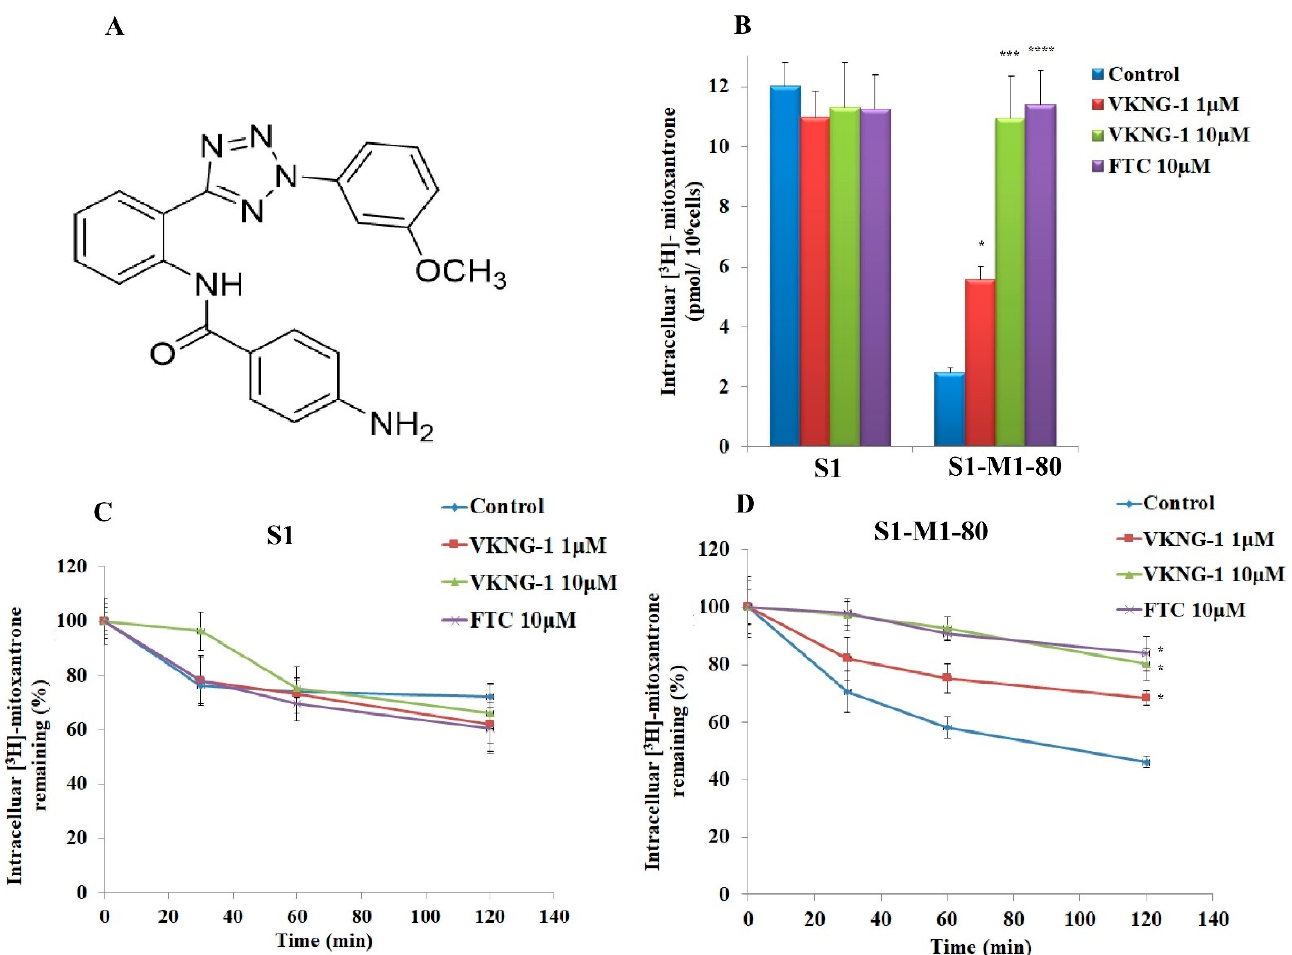
Figure 2. Chemical structure of VKNG-1 ( A ). The outcome of VKNG-1 activity on the cellular accumulation of ( 3 H)- mitoxantrone in S1 and S1-M1-80 cells ( B ). Data of VKNG-1 on the efflux of the substrates of ABCG2. A graph was plotted with time course (0, 30, 60, 120 min) on the X -axis versus the percentage of intracellular ( 3 H)-mitoxantrone remaining (%) on the Y -axis and showed the effect of VKNG-1 in S1 ( C ), S1-M1-80 ( D ) cells. Columns depict triplicate determinations; the error bars represent the SD. FTC at a concentration of 10 µ M is used as an ABCG2 positive control inhibitor. * p < 0.05 and *** p < 0.001 compared to the control group. If p -value < 0.05, it is statistically significant and **** p < 0.001 is considered to be statistically highly significant.